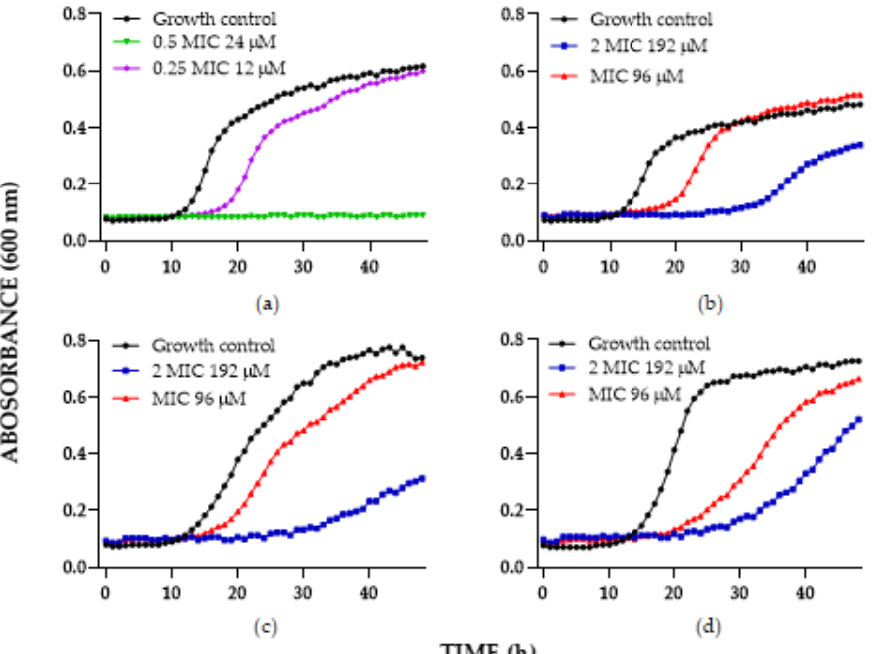
Figure 2. Time-kill curve of chimera C6 against: ( a ) C. glabrata 2001, ( b ) C. glabrata 1875, ( c ) C. auris 001, ( d ) C. auris 537. The MIC value corresponds to the concentration obtained by the broth concen- tration method.